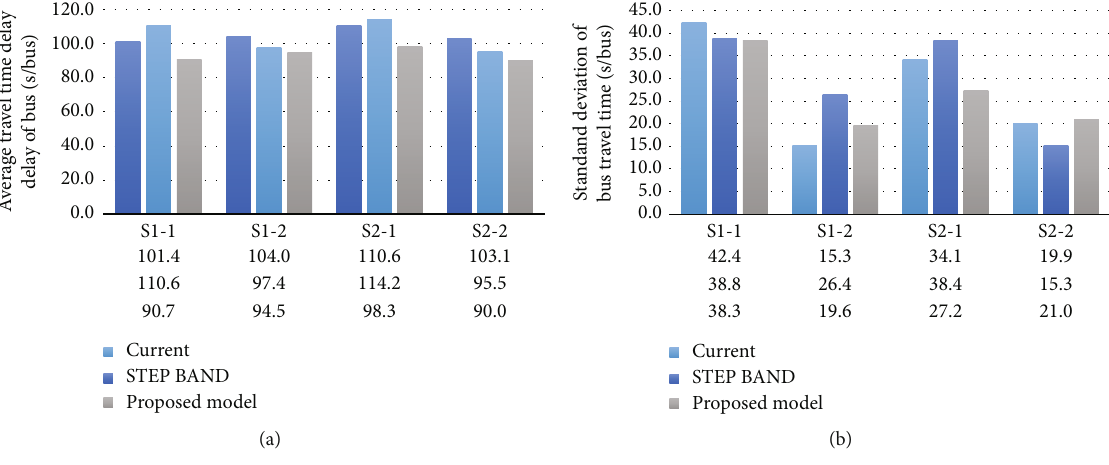
Figure 9: Bus travel-time delays (s/veh) for three models in four scenarios: (a) averages and (b) standard deviations.